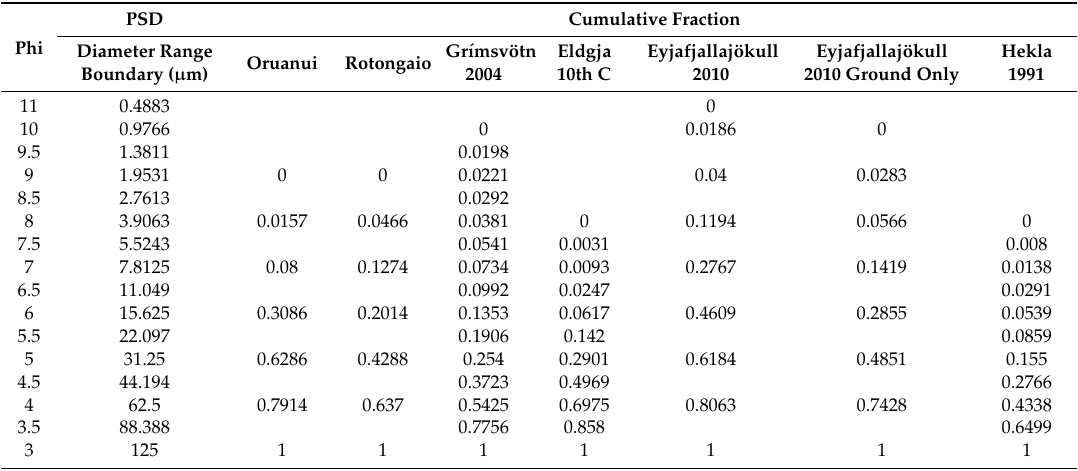
Table A1. Input file particle size distributions and cumulative mass fractions for NAME